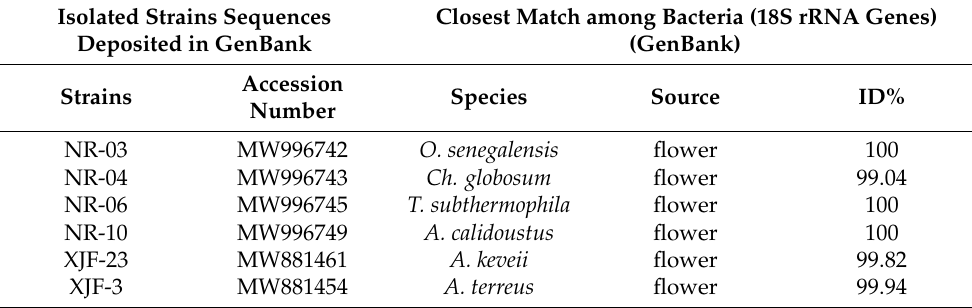
Table 1. Sequence similarities of endophyte fungi isolated from aerial parts of V. anthelmintica with sequences registered in GenBank.